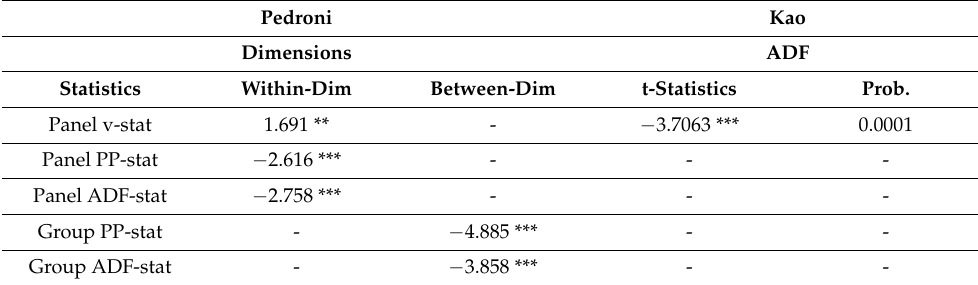
Table 5. Cointegration